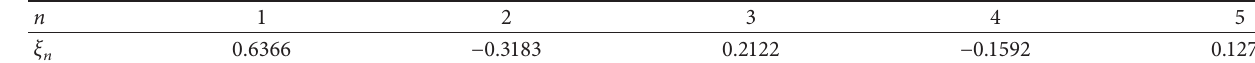
Table 3: Generalized load coefficients of the riser with subsea BOP.